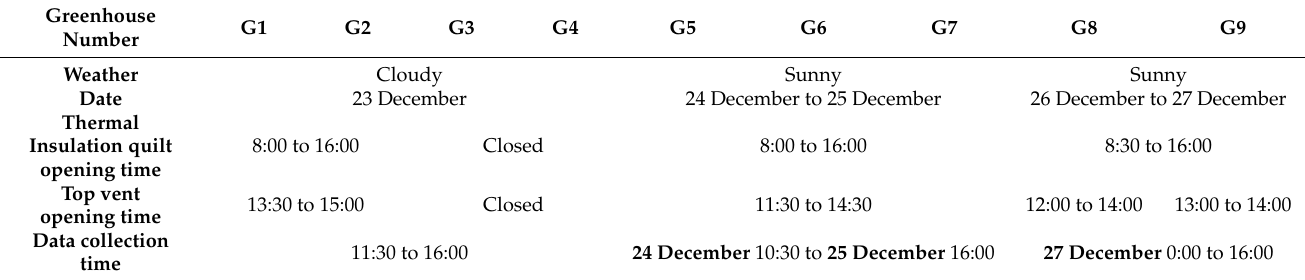
Table 4. Basic experimental